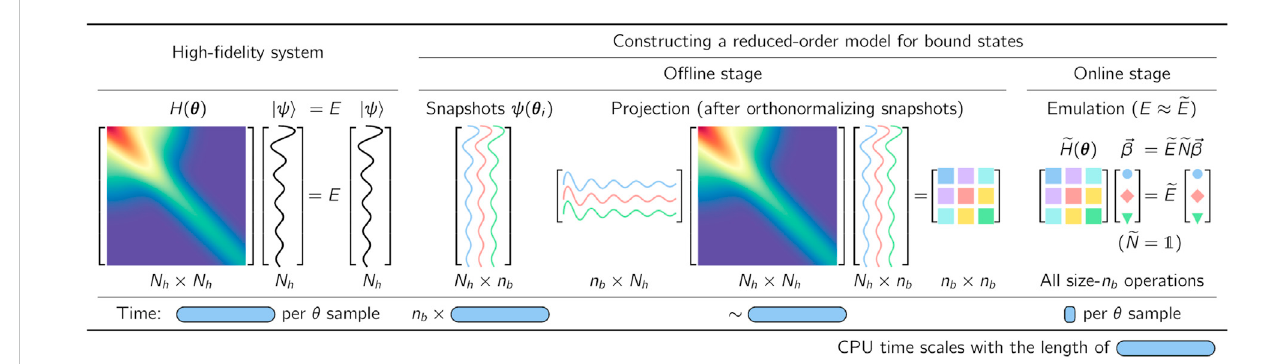
FIGURE 2 Illustration of the work fl ow for implementing fast and accurate emulators, including a high- fi delity solver (left) and an intrusive, projection-based emulator with ef fi cient of fl ine-online decomposition (right), for sampling the (approximate) solutions of the Schrödinger Eq. 1 in the parameter space θ . For brevity, the fi gure assumes that the snapshots are orthonormalized during the of fl ine stage such that ~ N (cid:2) 1 in the emulator Eq. 5. See the main text for